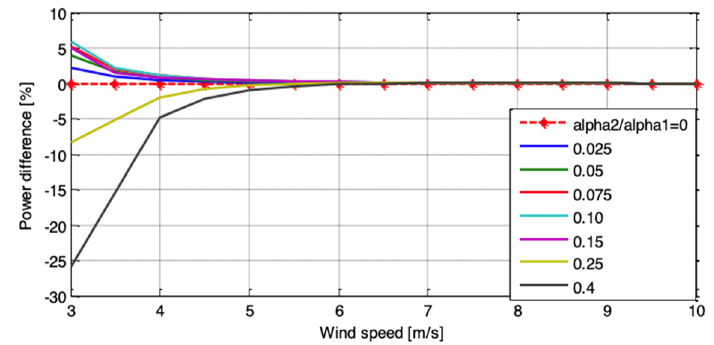
Figure 5. Output power difference at different α 2